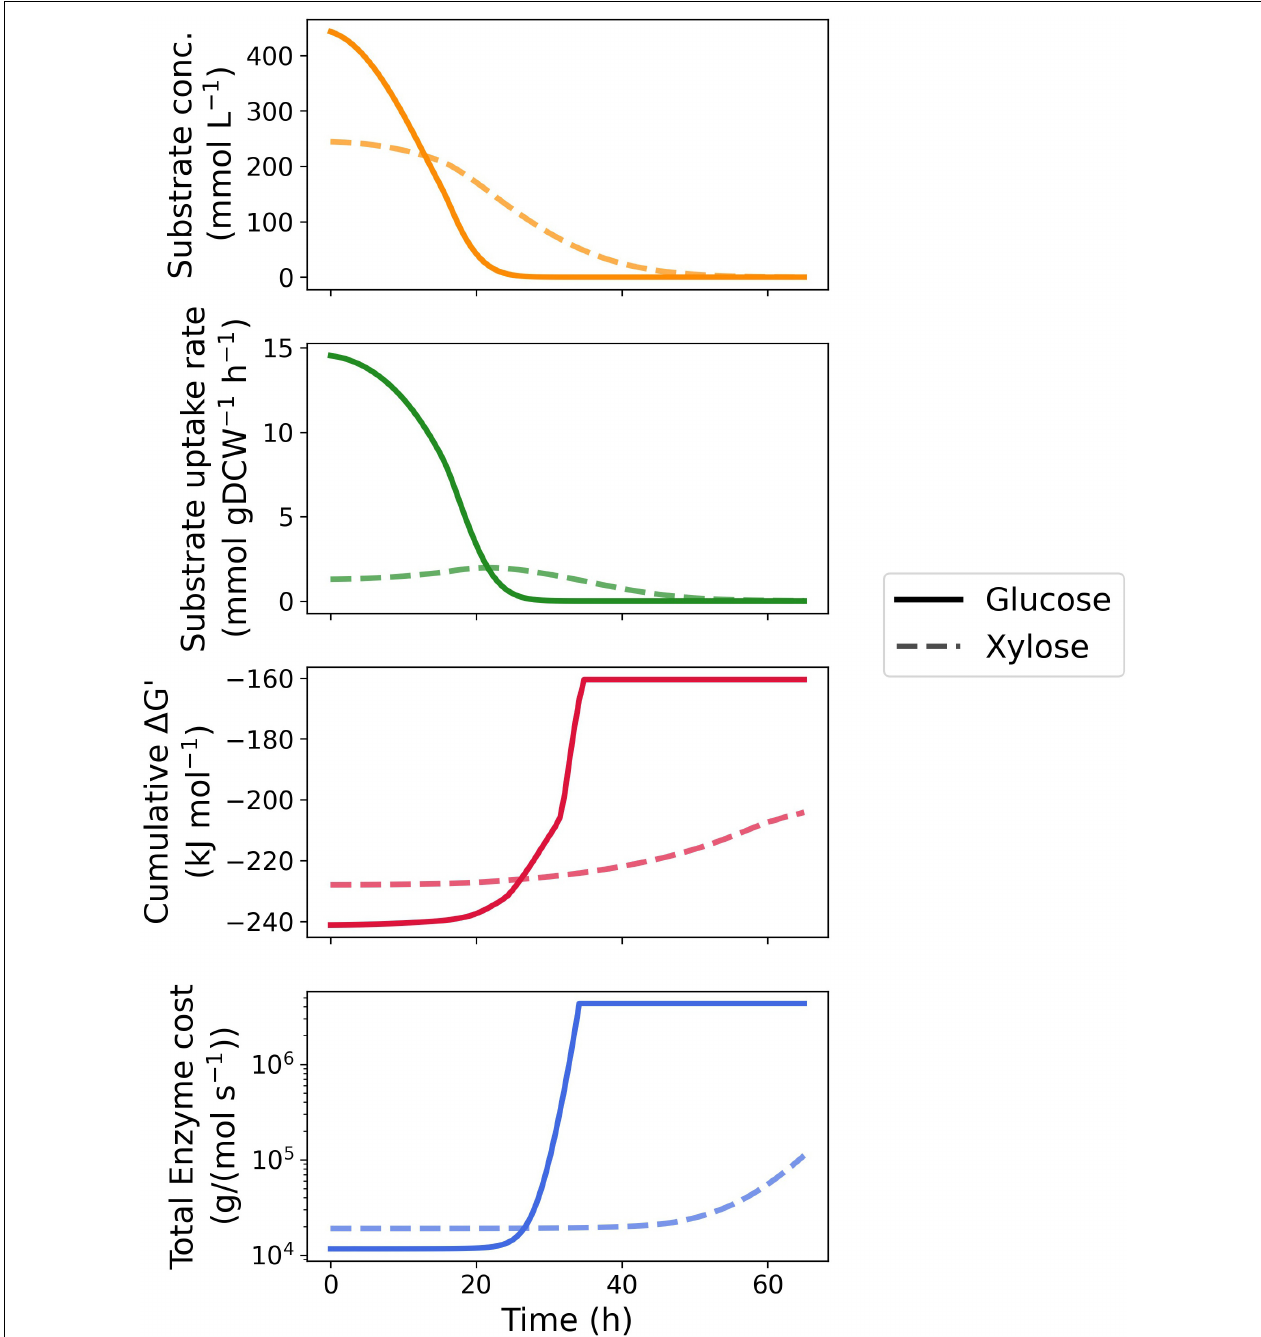
FIGURE 3 | Time-course kinetic and thermodynamic profile of glucose and xylose metabolism by Z. mobilis BC42C (cid:49) pdc. Substrate concentrations constituted the fitting curve of experimental data. Specific substrate uptake rates were calculated as the first derivative of substrate concentrations divided by corresponding biomass concentrations. MDF optimization and enzyme protein cost estimation were performed at 100 equally spaced timepoints during fermentation with substrate concentration fixed at corresponding values. Only total cumulative (cid:49) G (cid:48) and protein cost were illustrated, see Supplementary Figures 1 , 2 for results of individual